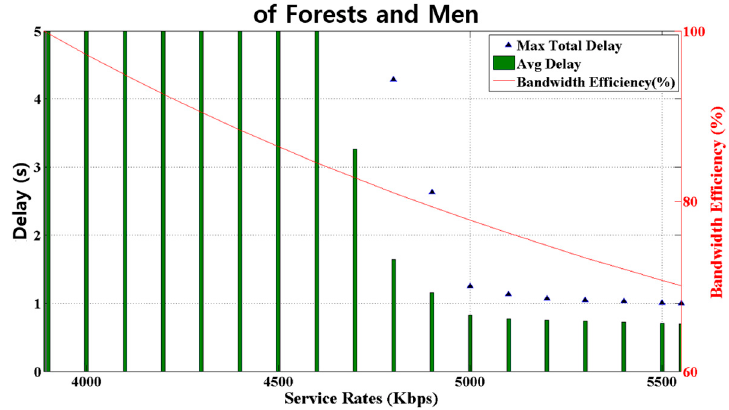
Table 4. Simulation results of ‘Big Buck Bunny’.